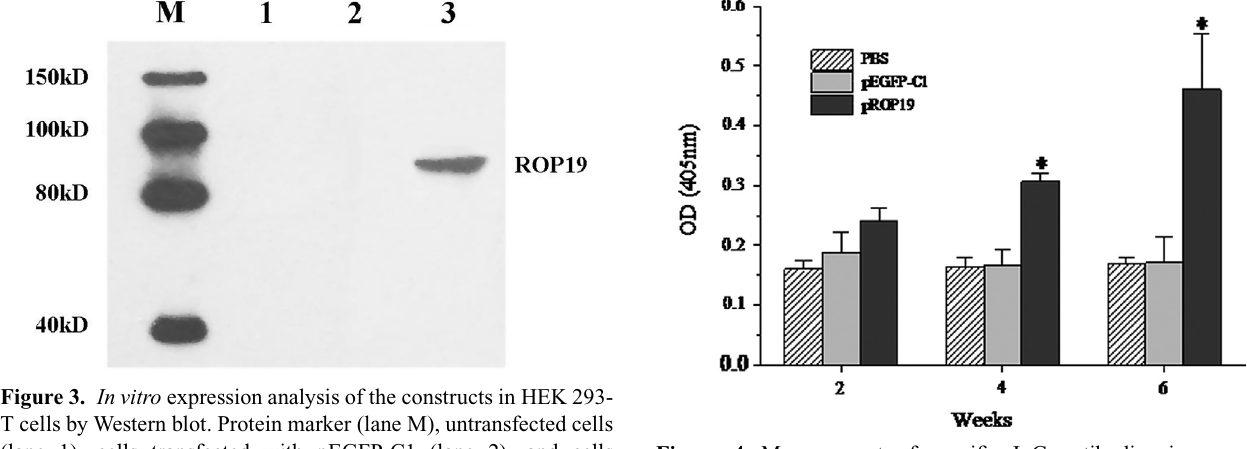
Figure 4. Measurement of specific IgG antibodies in sera of immunized mice. Sera were collected two days prior to each immunization and determined by ELISA. All samples were run four times. The results are the mean of three independent experiments and expressed as the mean of OD 405 ± SD. The statistical differences ( p < 0.05) are indicated by *compared with PBS or